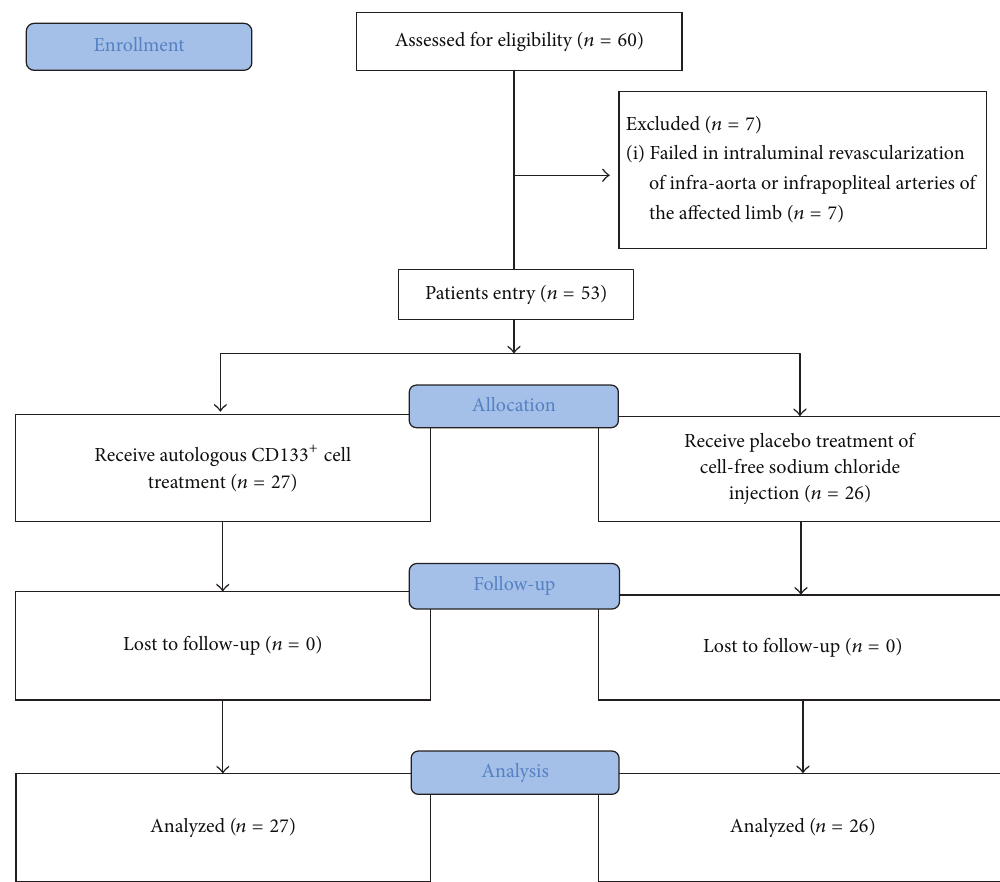
Figure 1: Flow diagram; suggested representation of the flow of participants in a series of diabetic PAD trials.